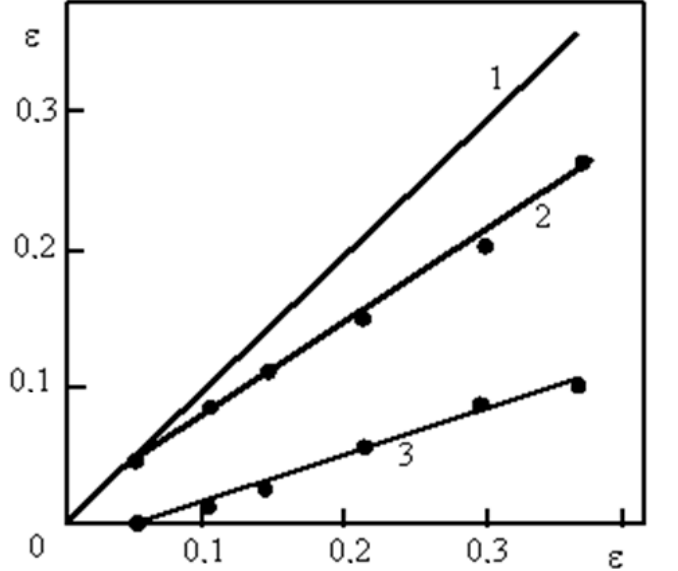
Figure 9. Contribution of dislocations ( 2 ) and microtwins ( 3 ) to the total plastic deformation ε ( 1 ).